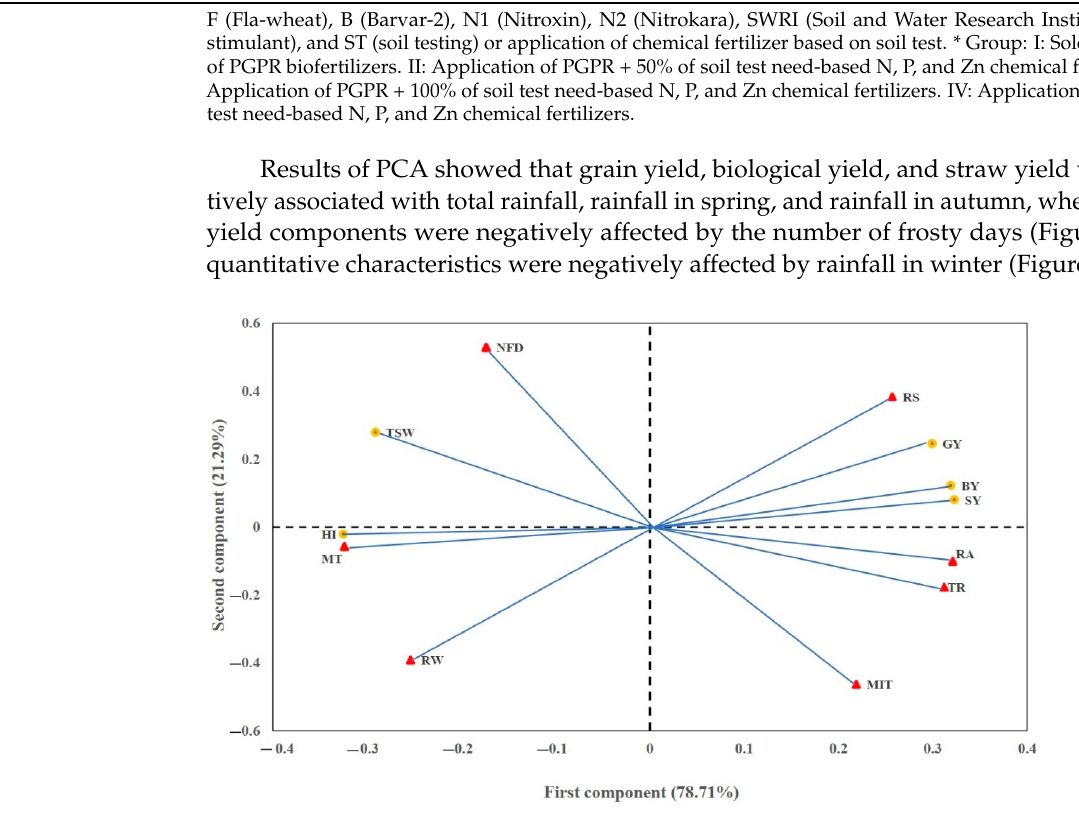
Figure 2. Biplot based on principal component analysis of the quantitative characteristics of the Azar-2 rainfed wheat cultivar during three studied growing seasons. BY (biological yield), GY (grain yield), HI (harvest index), MT (mean temperature), MIT (minimum of temperature), NFD (number of frosty days), RA (rainfall in autumn), RS (rainfall in spring), RW (rainfall in winter), SY (straw yield), TR (total rainfall), TSW (1000-seed weight).